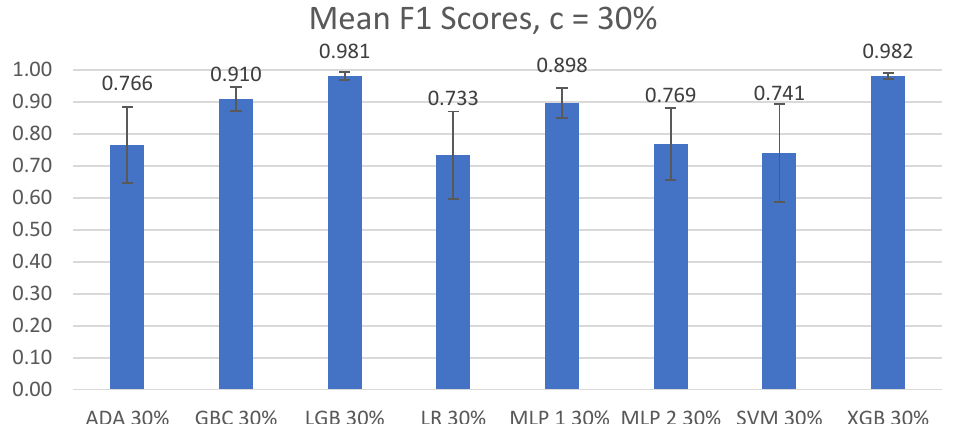
Figure 4. Mean F1 scores of left-side lying, supine, or right-side lying classification by model for the incremental learning level c = 30%. Error bars represent standard deviations.